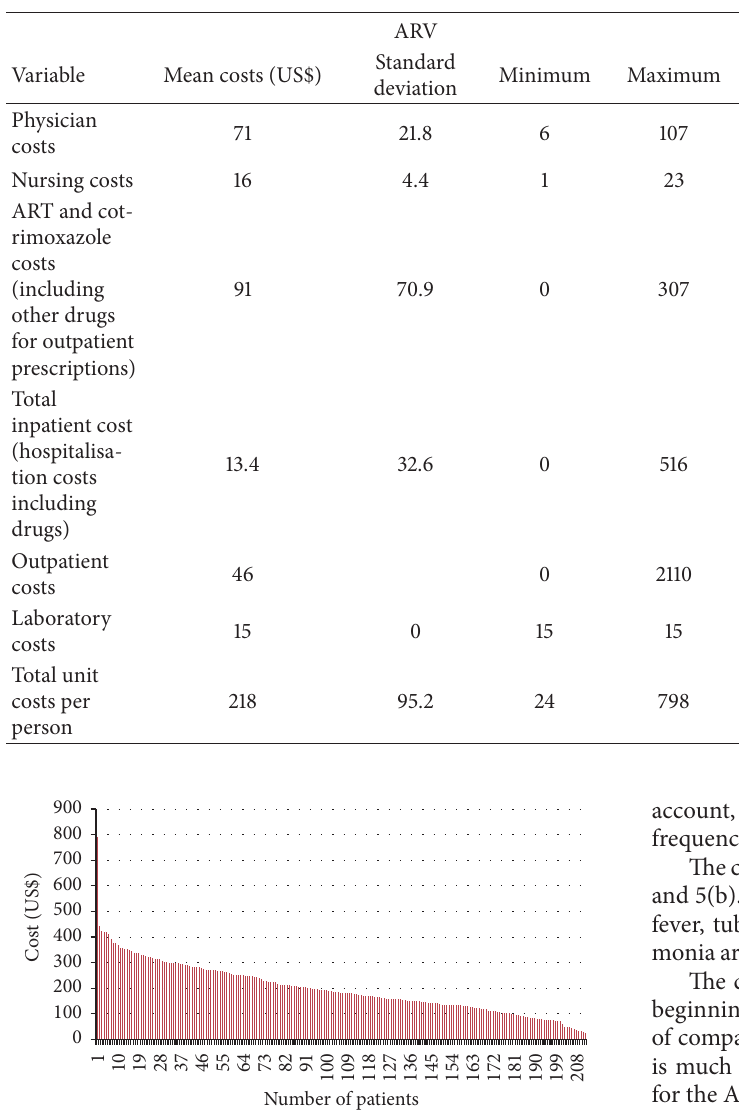
Table 4: Average costs for cotrimoxazole and ARV medications.